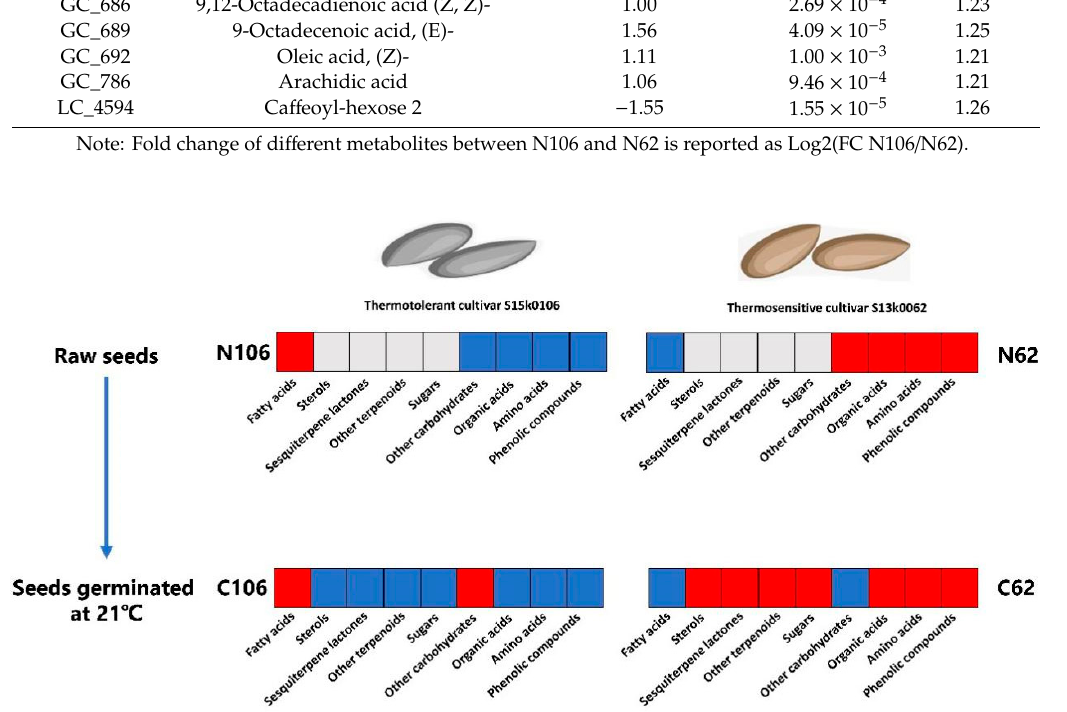
Table 1. Differential metabolites extracted from S15k0106 (N106) seeds and S13k0062 (N62) seeds.